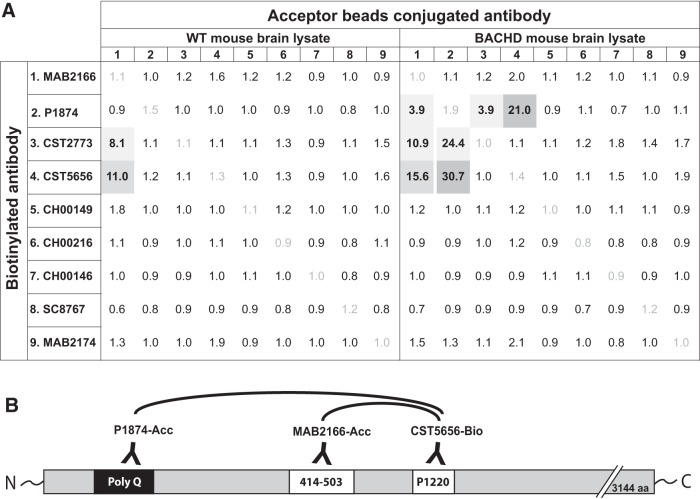
Antibody screening for the HTT AlphaLISA assay. Signal-to-background ratios obtained in the screening steps for the polyQ-dependent and -independent AlphaLISA assays are presented for each pair of antibodies tested. Antibody combinations producing a signal-to-background ratio different from 1 are represented in gray, with selected antibody combinations for the HTT AlphaLISA in dark gray (A). Note that these experiments were conducted without optimization of the assay conditions for each antibody pair. Schematic representation of the antibodies selected for the AlphaLISA assay and their binding sites on the HTT protein. The biotinylated antibody (CST5656) is combined with Acceptor bead-conjugated antibodies: MAB2166 for the polyQ-independent assay and P1874 for the polyQ-dependent assay (B).